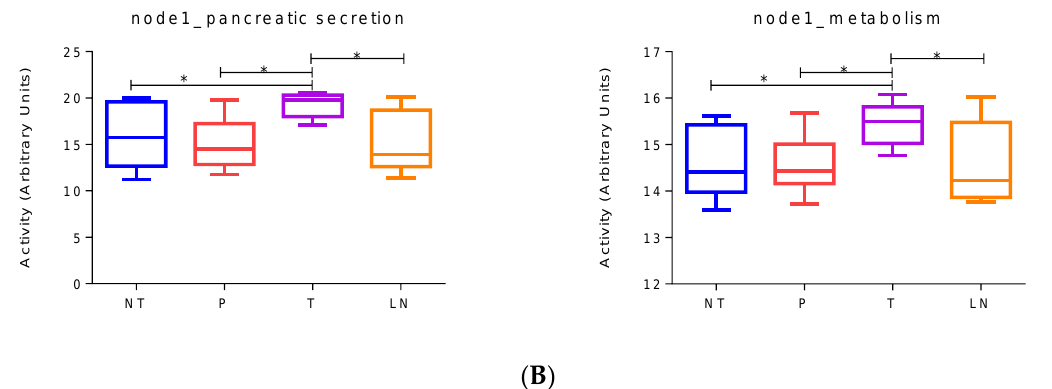
Figure 4. ( A ). Network of 2311 proteins in the T2 subtype. ( B ) Differential functional node activities comparing the different histological samples in the T2 subtype according to mixed lineal models. NT = normal tissue, P = preneoplastic lesions, T = primary tumors, LN = lymph nodes. * p < 0.05.